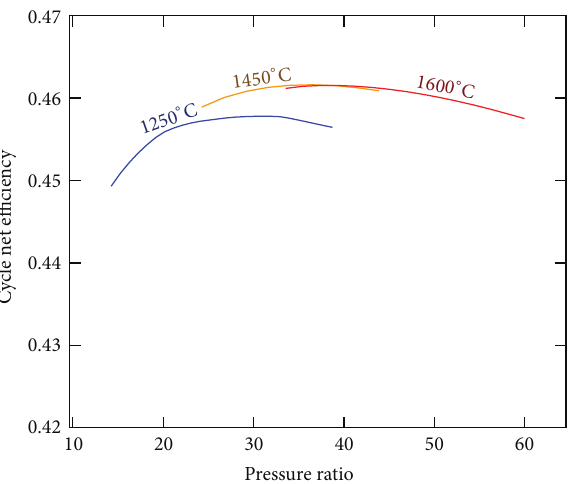
Figure 13: Cooling mass flow ratio as function of pressure ratio and the turbine entry temperature for the Graz